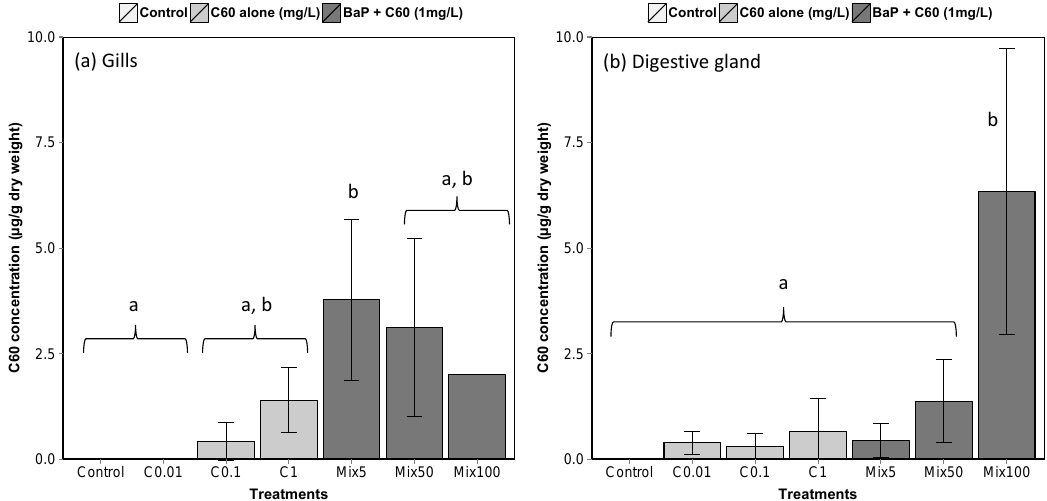
Figure 2. Liquid chromatography-mass spectrometry (LC–MS) analyses of C 60 in M. galloprovincialis ( a ) gills and ( b ) digestive gland (means ± SE). Data marked with different letters differed significantly